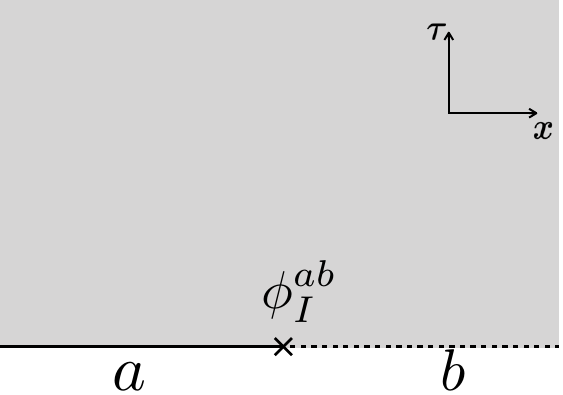
defined on an upper half plane. The superscript ab means that I are a and b , respectively. The subscript I labels I